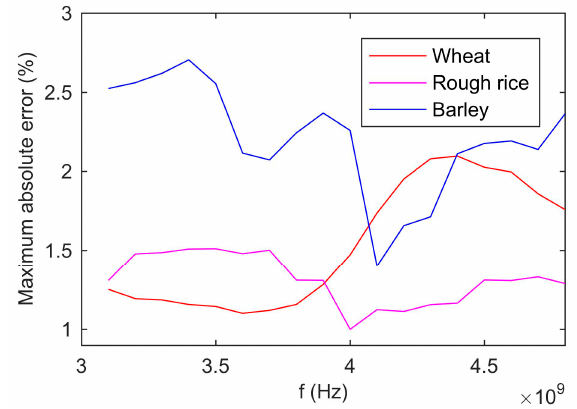
Figure 25. The influence of frequency on the accuracy of the moisture content measured results.